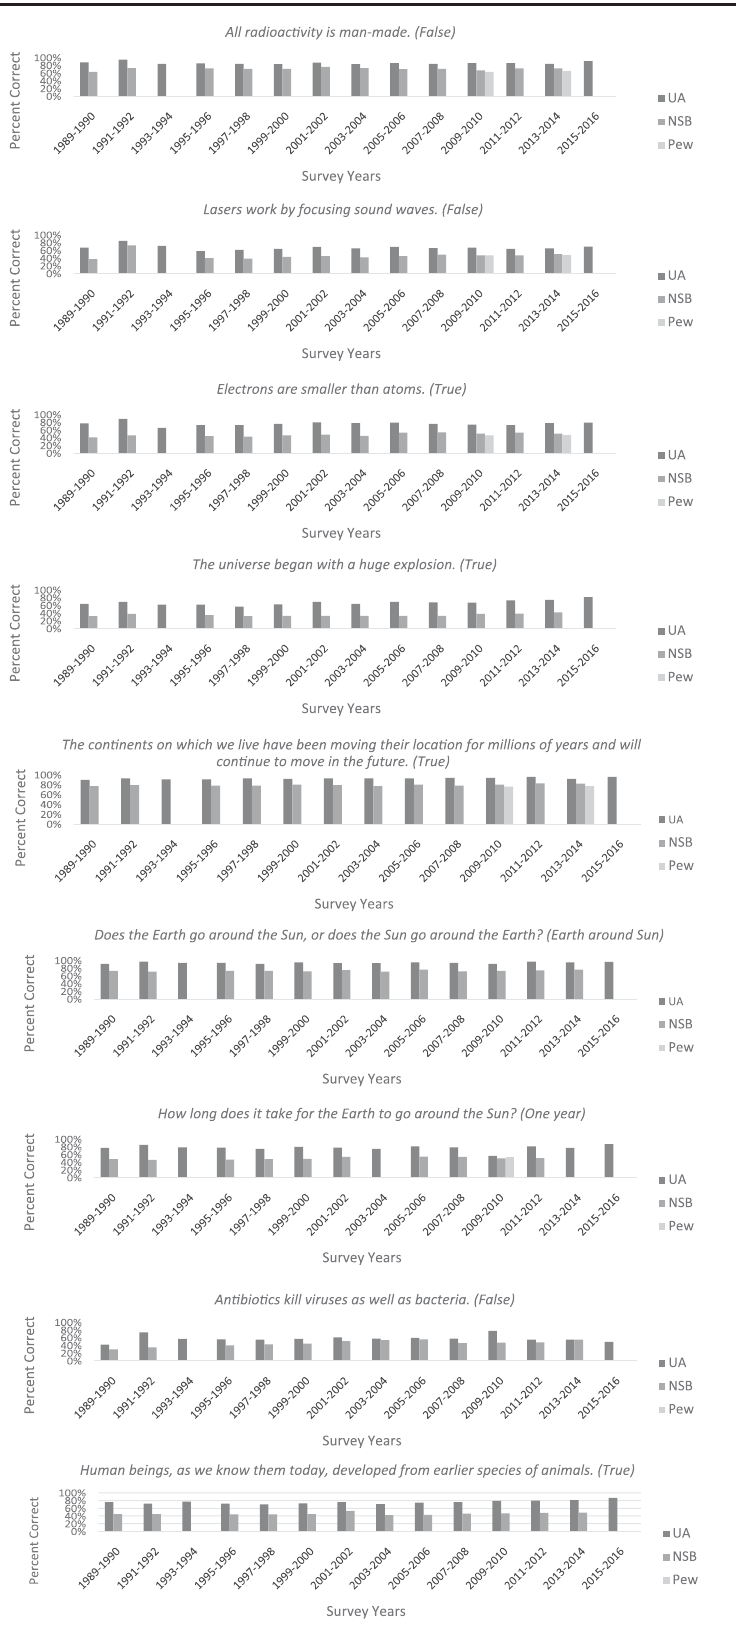
FIG. 2. Comparison of scores on common science knowledge questions on surveys from our sample of undergraduate students (UA), the surveys administered by the NSB, and the surveys administered by Pew Research Center